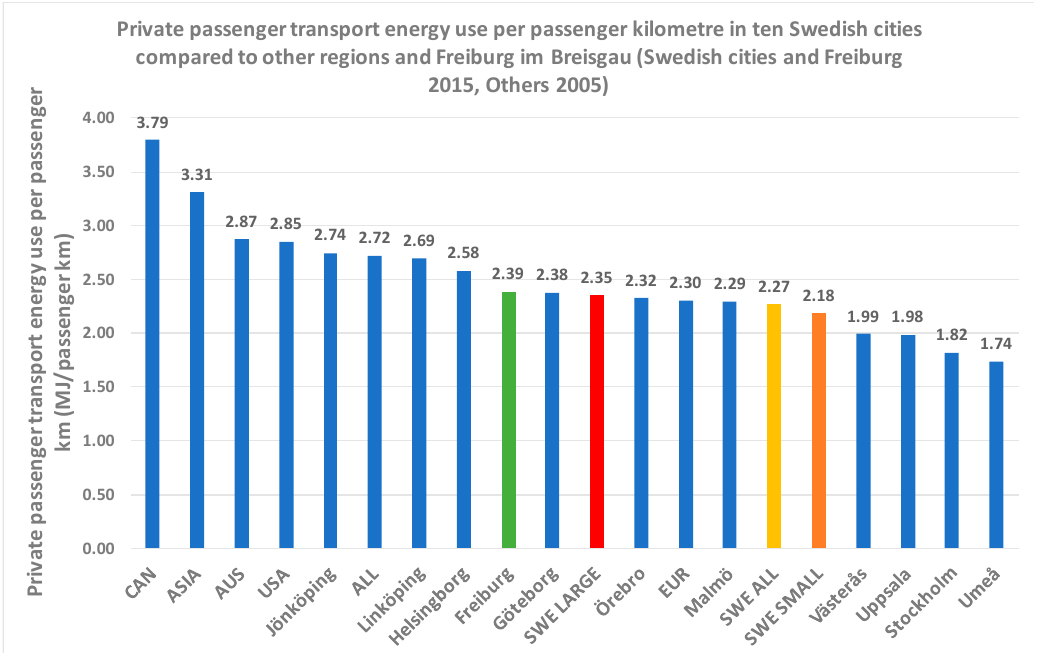
Figure 4. Energy use per passenger kilometer (PKT) in private passenger transport in ten Swedish cities (2015); Freiburg (2015); and American, Australian, Canadian, European and Asian cities (2005– 2006).